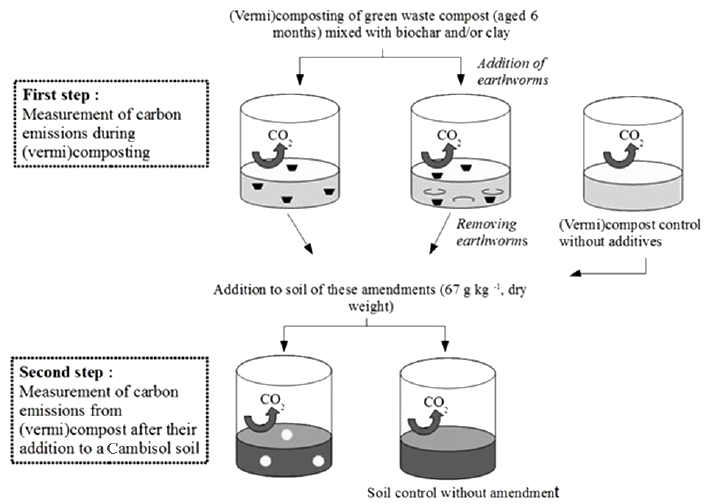
Figure 1. Experimental design to compare CO 2 emissions of different organic materials during composting and after their addition to